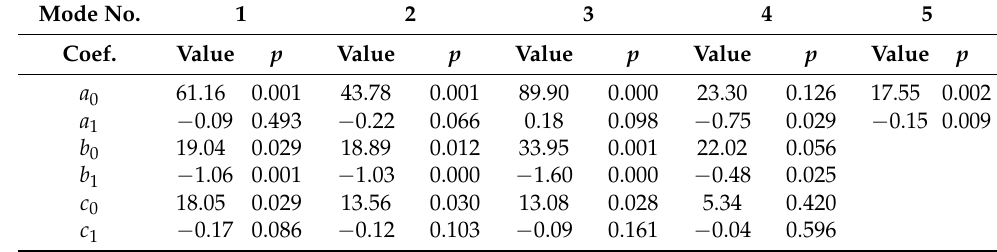
Table 5. Piecewise linear approximation coefficients of Al content (%) in the bimetal interface zone.